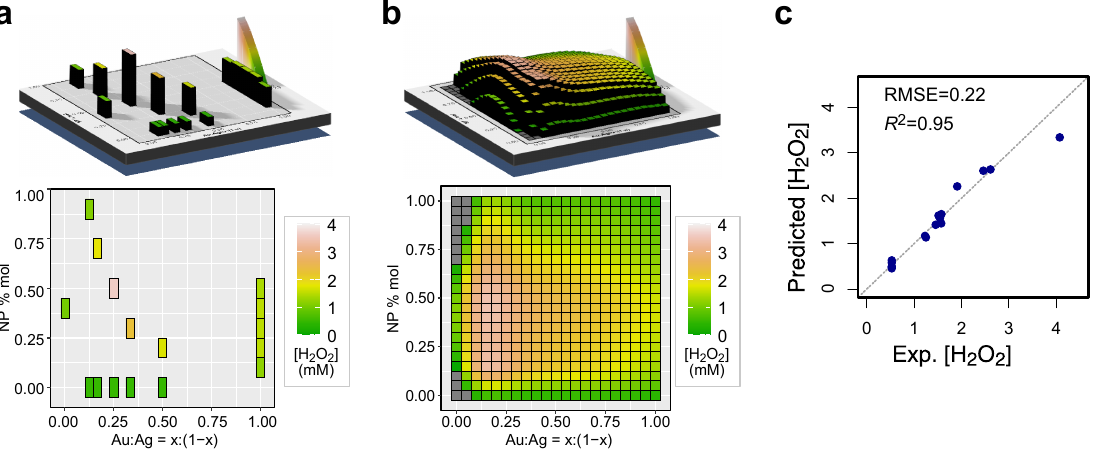
Figure 4. ( a ) Heatmap of reported [H 2 O 2 ]. ( b ) Heatmap of the calculated [H 2 O 2 ] in this work. ( c ) Pair-wise comparison of the accuracy of the amount of produced H 2 O 2 in mM. For H 2 O 2 concentration, [ H 2 O 2 ] = ( k f / k d ) { 1 − exp ( 1 − k d t ) } , and t = ∞ .